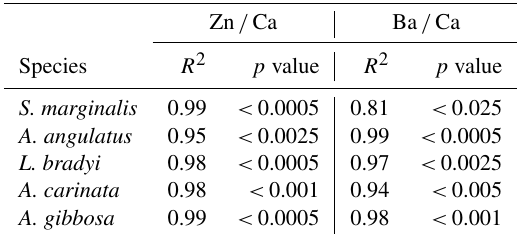
Table 4. Regression and p values of foraminiferal Zn / Ca and Ba / Ca versus p CO 2 values of different species (Fig. 4). Zn / Ca Ba / Ca Species R 2 p value R 2 p